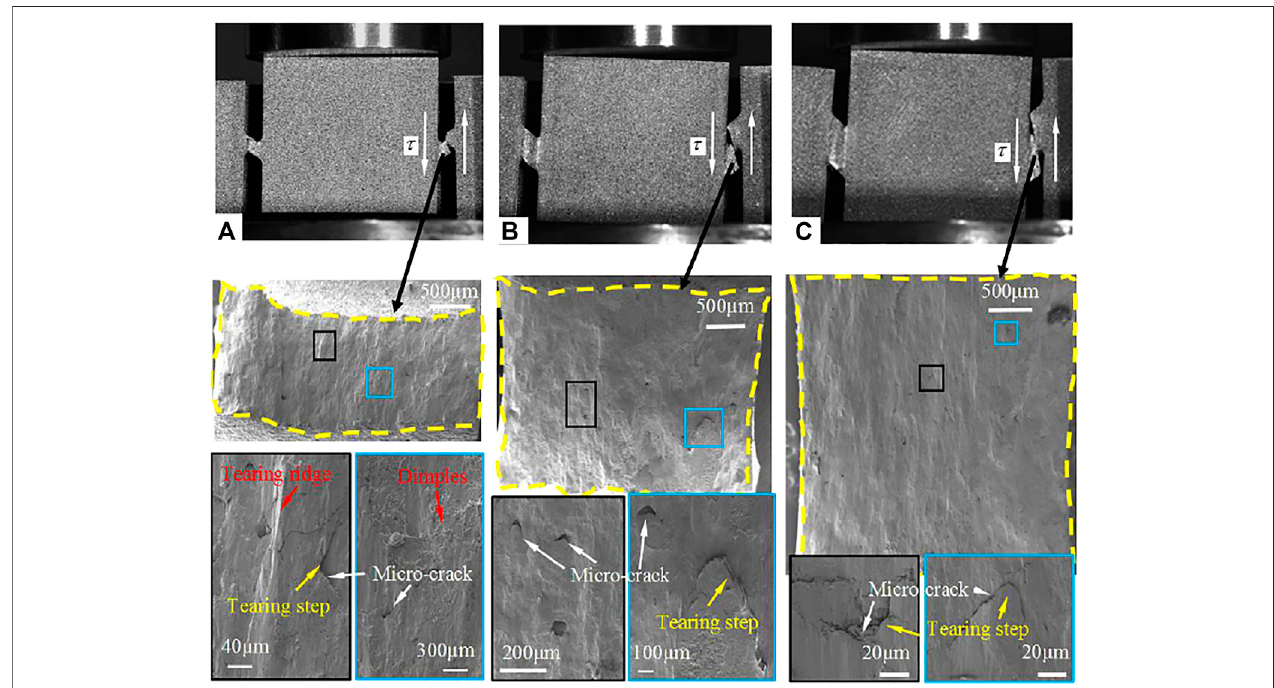
FIGURE 10 | SEM images of the fracture surface of weld specimens with different welding lengths under quasi-static tests with a shear strain rate of about 0.001 s − 1 : (A) 2 mm weld specimen, (B) 4 mm weld specimen, and (C) 6 mm weld specimen.